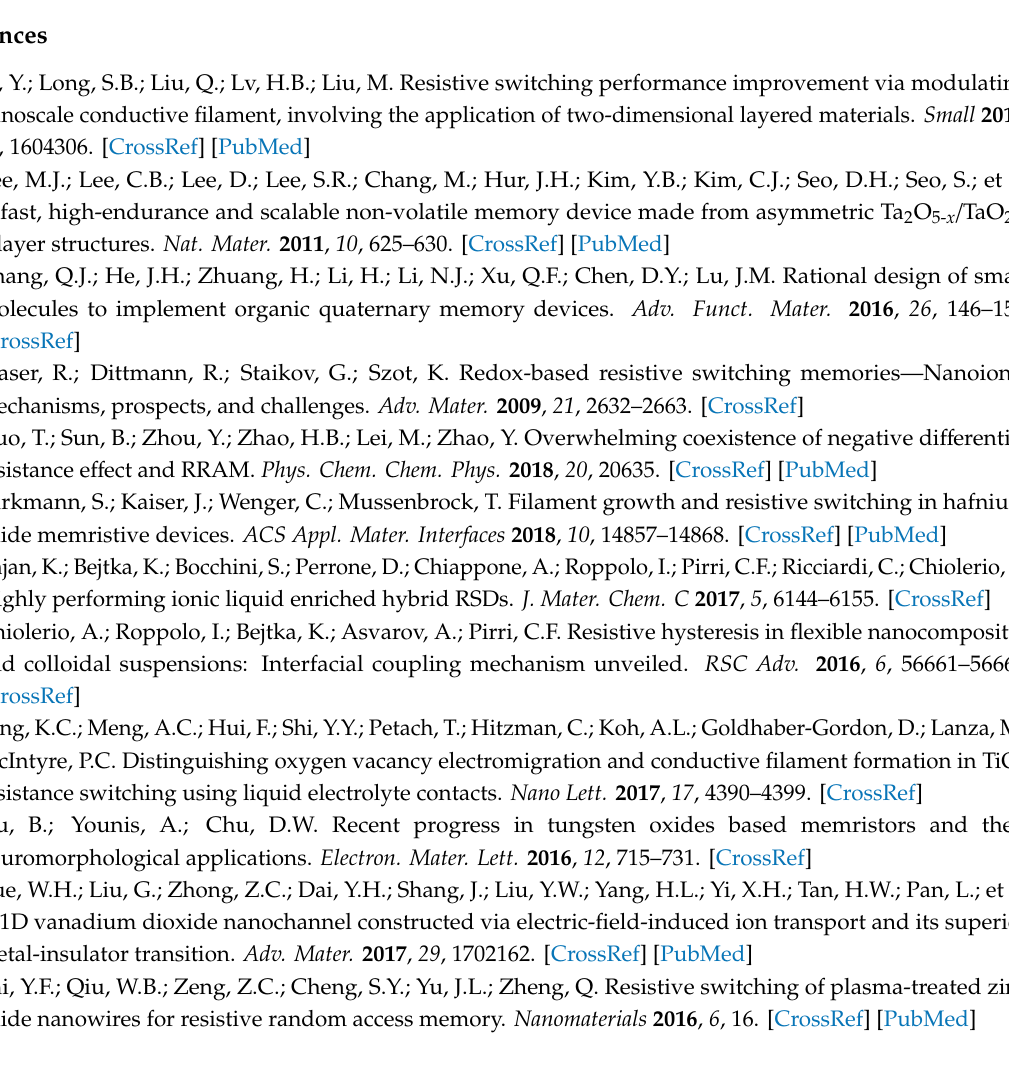
Figure S1: Topographic AFM image of grains in the as-deposited HfO x nanofilm, Figure S2: Topographic AFM images of the as-deposited HfO x nanofilm for positioning, (a) initial, (b) after electrical stimuli and (c) after OPT, Figure S3: Optical microscope images of the Pt top electrode in Pt / as-deposited HfO x / Pt device (a) before and (b) after resistive switching (RS)